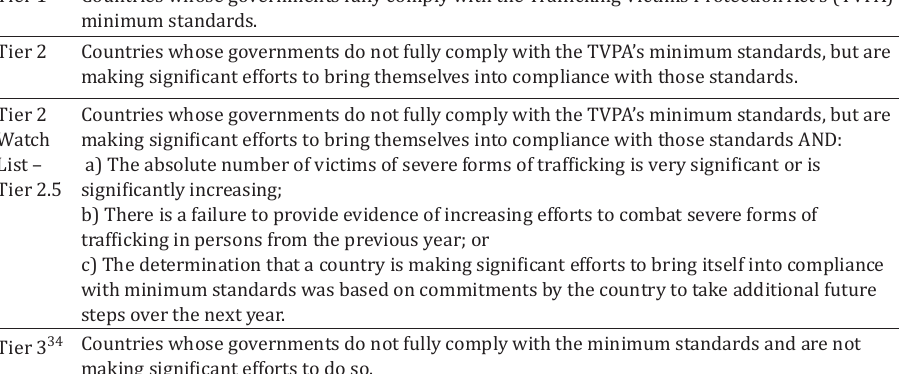
Table 3: Tiers according to U.S.